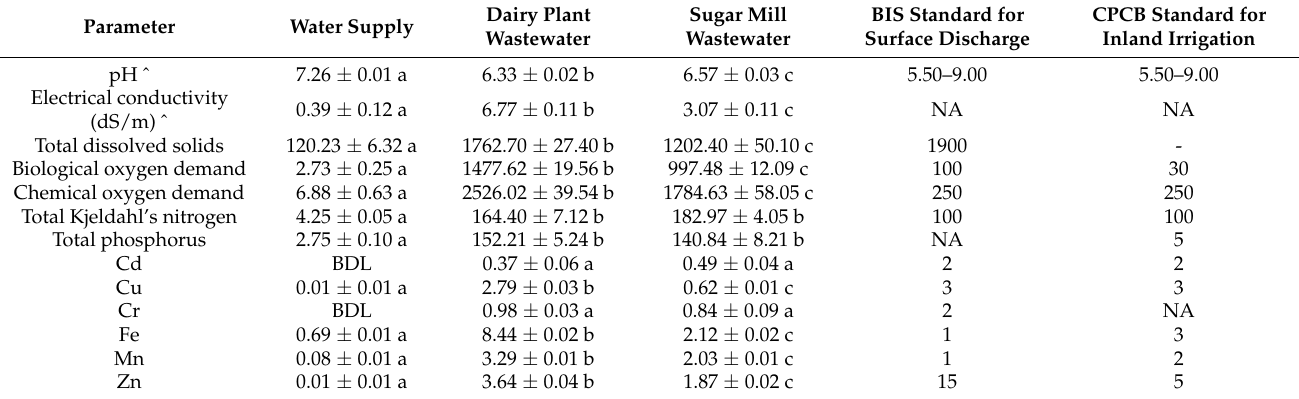
Table 1. Properties of water supply and agro-industrial wastewaters used in the current study (mean ± SD of five